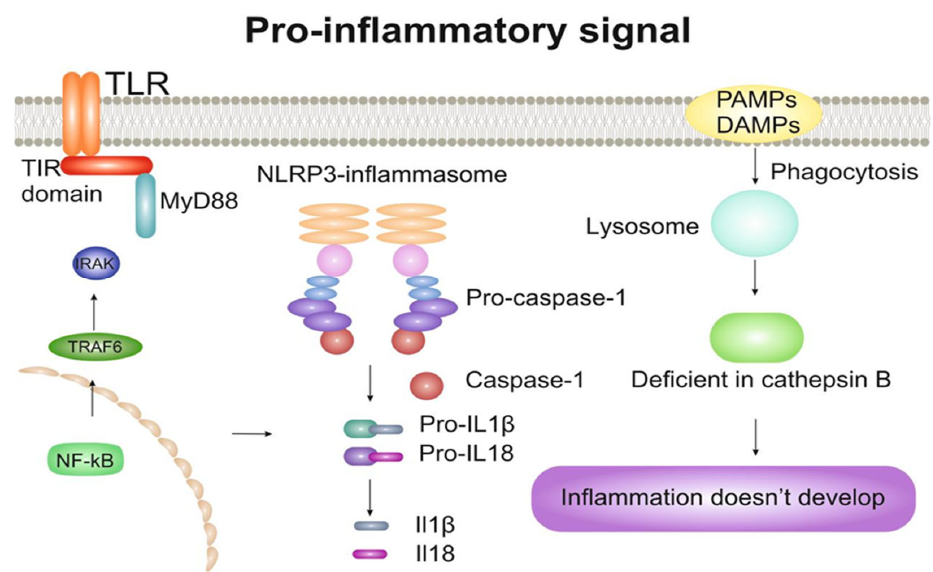
Figure 2. Pro-in fl ammatory signaling pathways in the cell. Figure 2. Pro-inflammatory signaling pathways in the